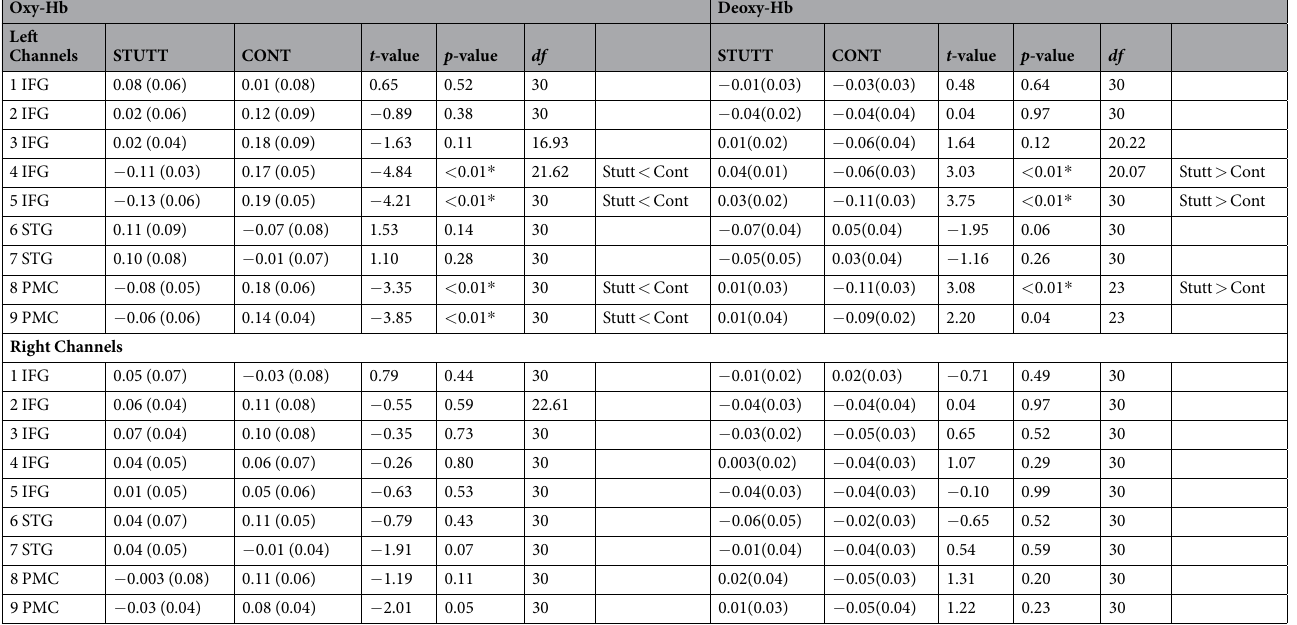
Table 2. Relative Oxy-Hb and Deoxy-Hb concentrations M (SE) μ M and independent-samples t -tests for between-group comparisons of each channel: children who stutter vs. controls. * p ≤ 0.05, FDR-corrected. If Levene’s Test for Equality of Variances was statistically significant for a comparison, t- statistics and degrees of freedom were adjusted using the Welch-Satterthwaite method. df = degrees of freedom; IFG = inferior frontal gyrus, STG = superior temporal gyrus, PMC = premotor